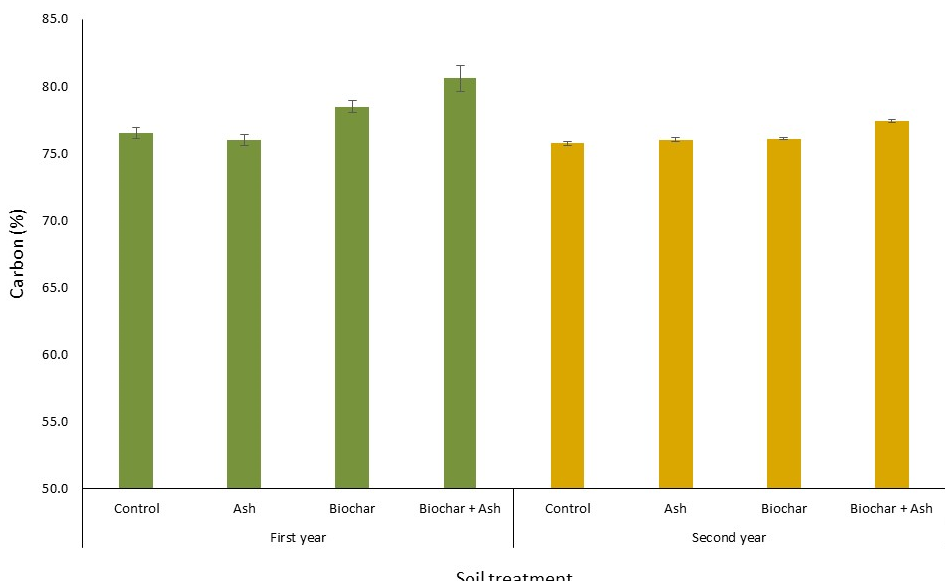
Figure 3. Pyrolysates’ carbon contents, produced from basket willow biomass collected from the control, ash, biochar, and biochar + ash soil treatment plots, one and two years after planting ( n = 12). In accordance with the result of the Bonferroni test, the carbon values were not significantly (α ≤ 0.05) different among treatments (separate comparison for each year).